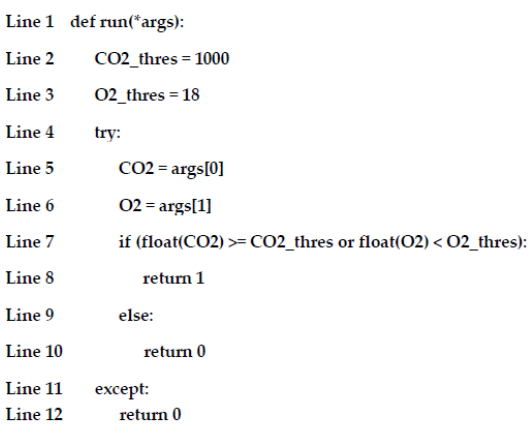
Figure 7. Function code in the experiment.